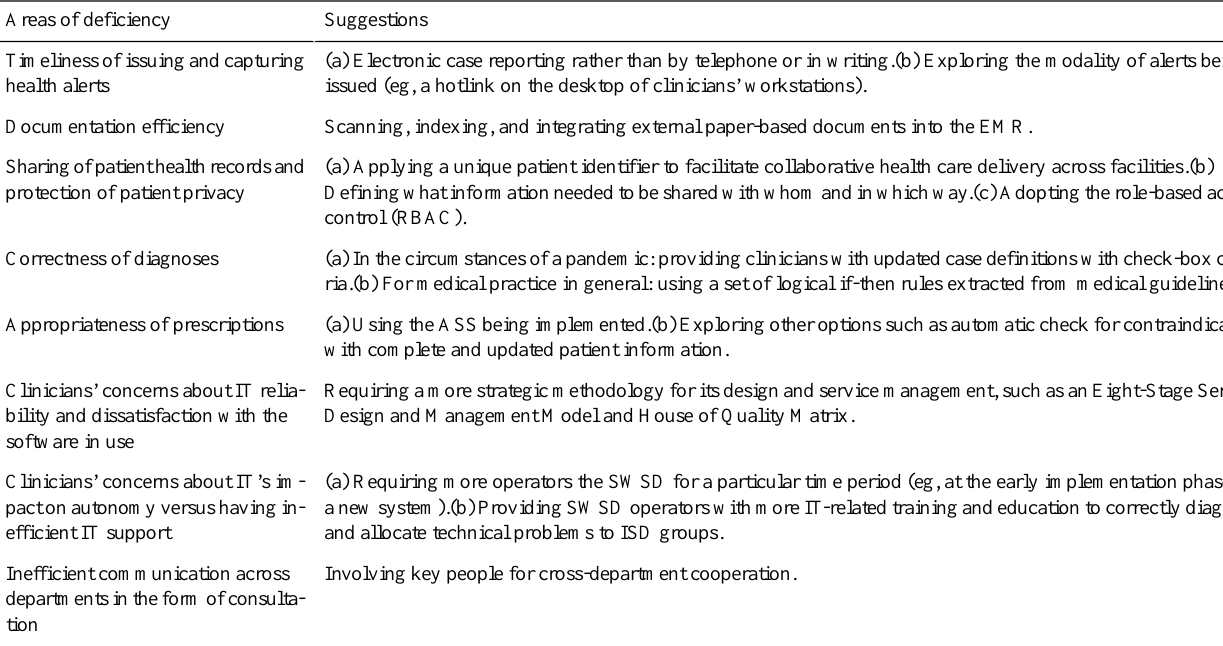
Table 1. Identified areas of deficiency and